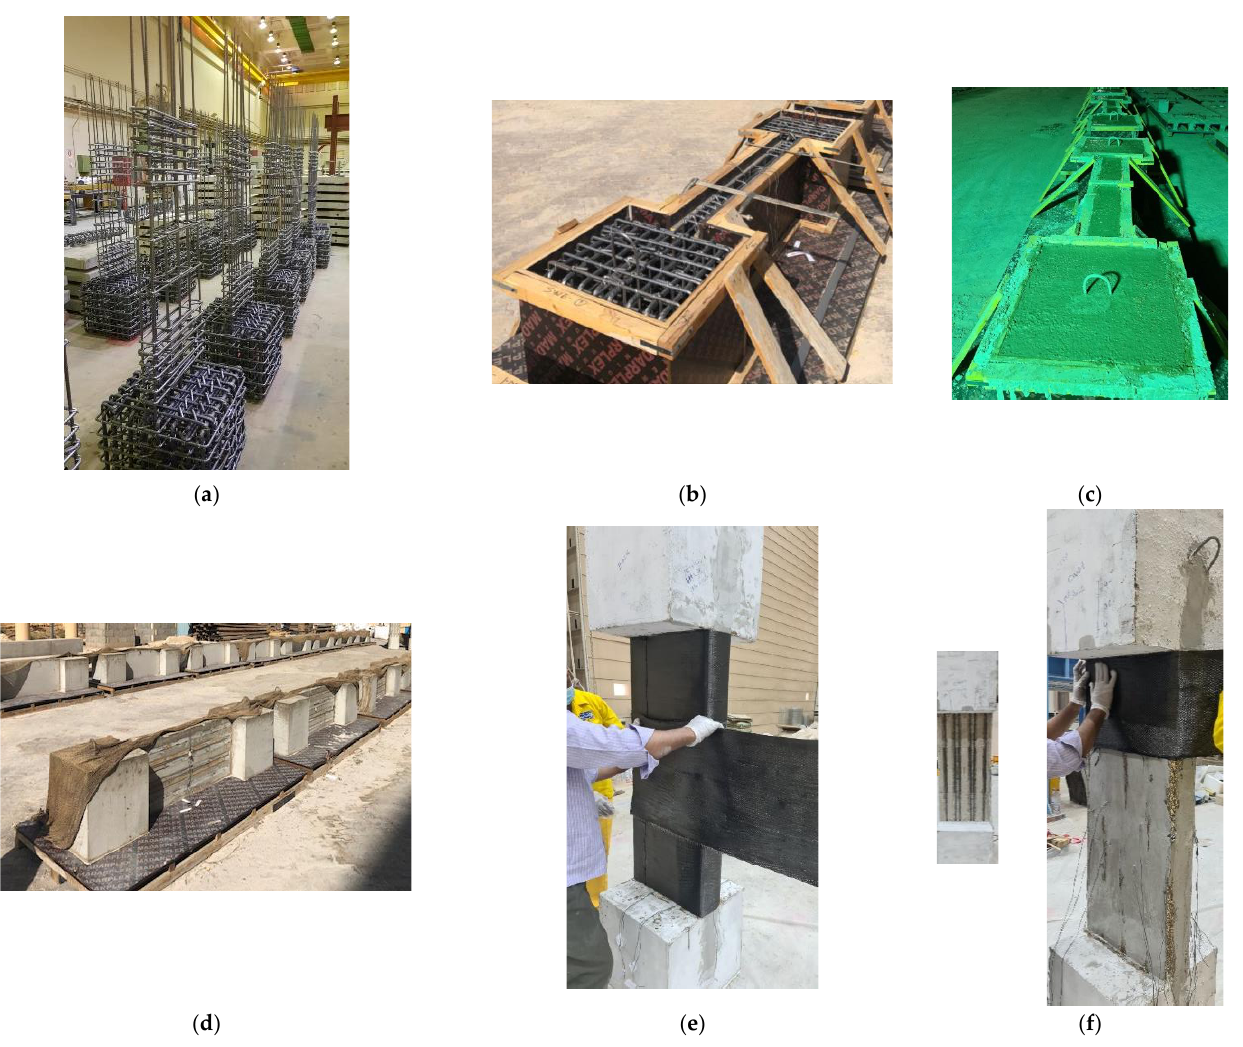
Figure 6. Preparation of test specimens: ( a ) rebar cages; ( b ) reinforcement cages in the formworks before casting of concrete; ( c ) test specimens after casting; ( d ) test specimens ready for testing and strengthening; ( e ) strengthening of column with scheme-1 using CFRP sheets (SW1); and ( f ) strengthening of column with scheme-2 using CFRP sheets combined with connected NSM rebars (SW2).